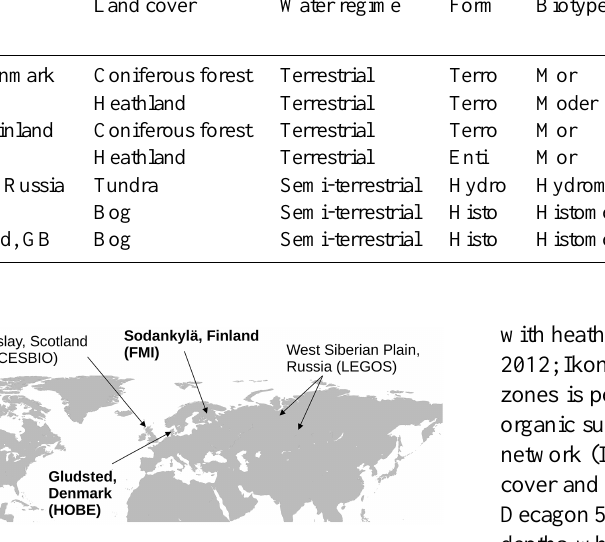
Figure 1. Overview over all sampling locations (main study sites are in